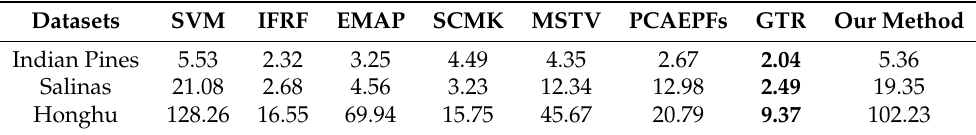
Table 6. The computing time of all considered approaches for all datasets. The bold denotes the best computing